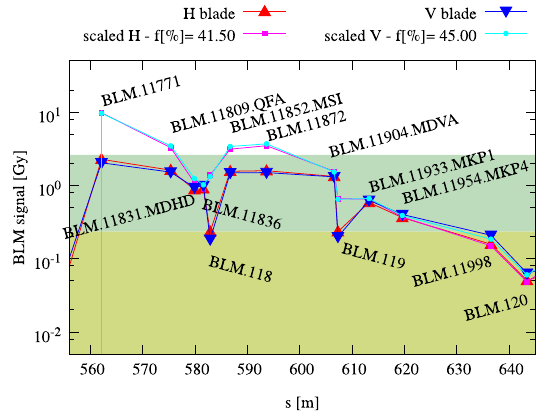
FIG. 12. Pattern of BLM signals in LSS1 during the endurance test of each blade, as measured (dark-colored curves) and as reconstructed with Eq. (2) (light-colored curves): horizontal (reddish curves) and vertical (blueish curves) blades. The percent- age in the key reports the reconstructed amount of scraped beam.